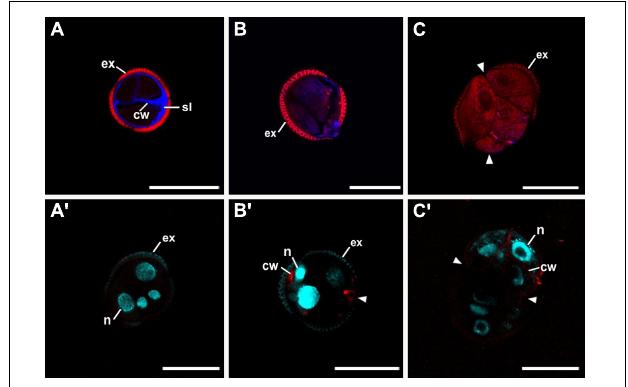
FIGURE 3 | Confocal microscopy images of EE structures at 2 (A,A (cid:48) ) , 5 (B,B (cid:48) ) , and 8 days of culture (C,C (cid:48) ) , stained with aniline blue for callose (blue in A–C ) together with propidium iodide (red), and with Direct Red for cellulose (red in A (cid:48) –C (cid:48) ) together with DAPI (blue). Arrowheads indicate regions of exine (ex) rupture or absence. cw, cell wall; n, nucleus; sl, subintinal layer. Bars: 20 µ